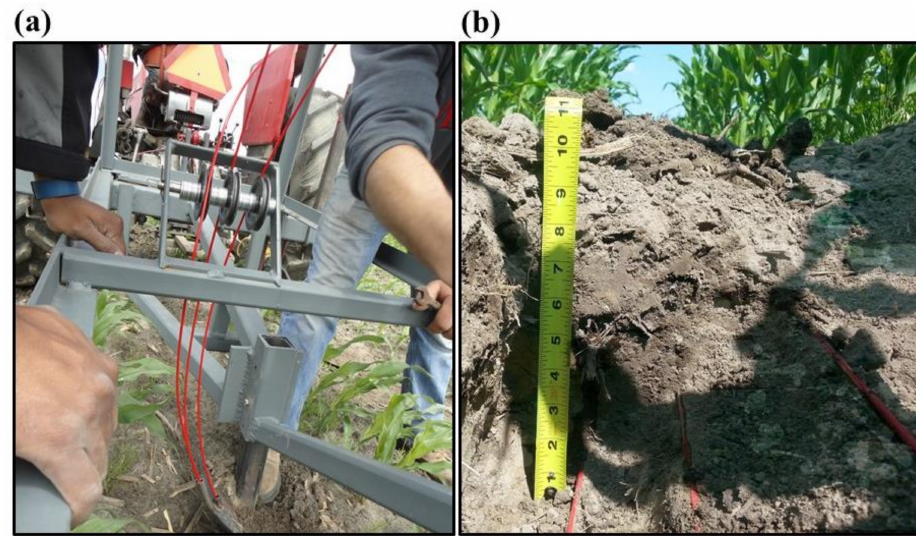
Table 1. User defined calibration included a correction for step loss whereas DTS inbuilt calibration had no correction for step loss prior to calibration.